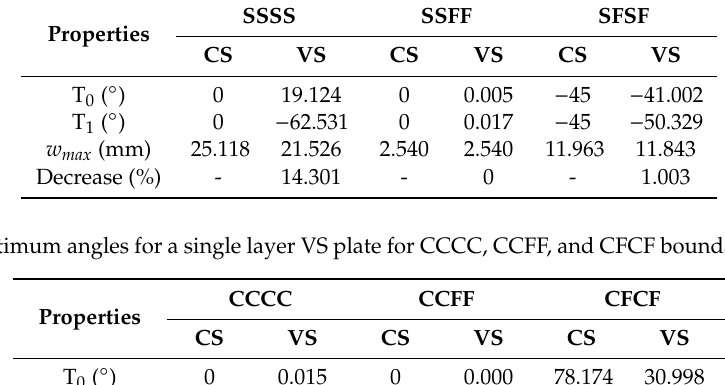
Table 9. Optimum angles for a single layer VS plate for SSSS, SSFF, and SFSF boundary conditions. SSSS Properties